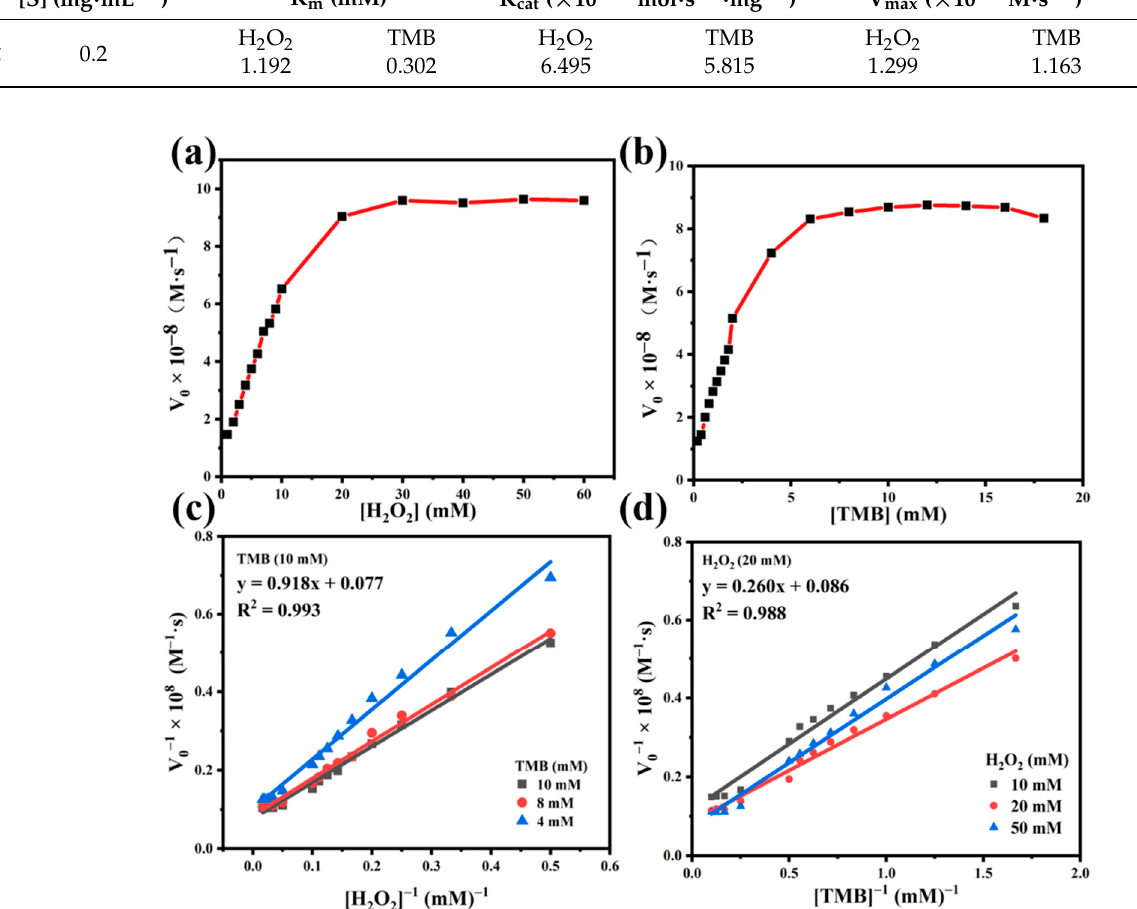
Figure 5. Steady-state kinetic assay and catalytic ability of Fe 3 O 4 @PEI@Ag structure: ( a ) and ( c ) to- ward [H 2 O 2 ], ( b ) and ( d ) toward [TMB].